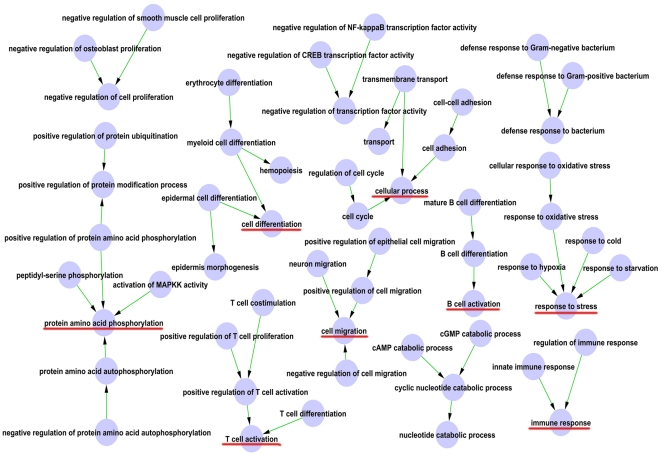
The interaction network of significant GO terms.The node represents one GO term, and the edge between two nodes represents the subordinate relationship between GO terms, with arrow from the lower ranking GO term pointing towards to the higher one.